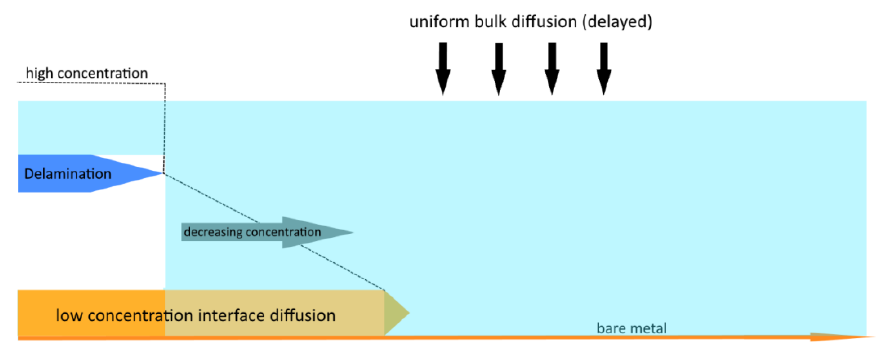
Figure 14. Overview of different processes of implant degradation from the outer rim (left) and via the volume (droplet top). At one point interface diffusion and bulk diffusion will merge and lead to an almost simultaneous, global delamination.